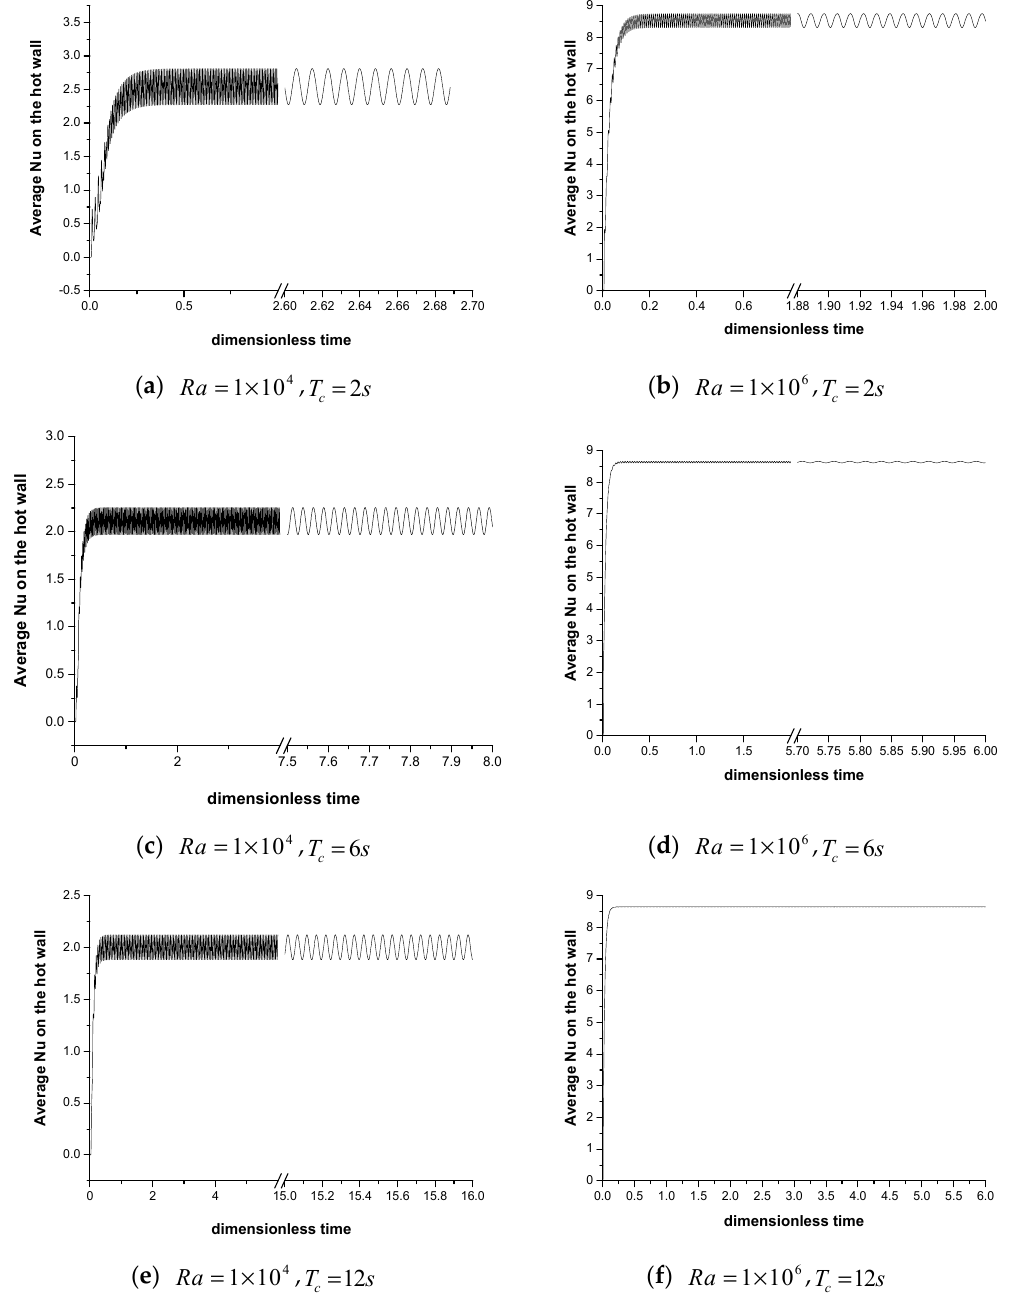
Figure 17. Average Nu on the hot face under di ff erent cases at ϕ m = π /4: ( a ) Ra = 1 × 10 4 , T c = 2 s ; ( b ) Ra = 1 × 10 6 , T c = 2 s ; ( c ) Ra = 1 × 10 4 , T c = 6 s ; ( d ) Ra = 1 × 10 6 , T c = 6 s ; ( e ) Ra = 1 × 10 4 , T c = 12 s ; ( f ) Ra = 1 × 10 6 , T c = 12 s